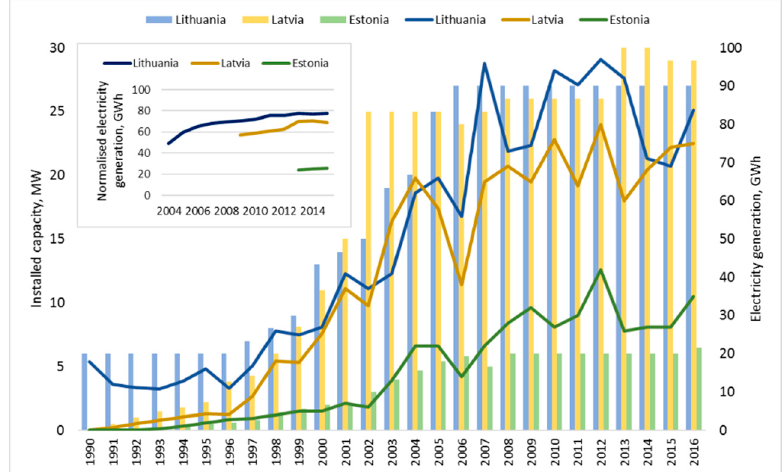
Figure 6. The installed capacity and electricity generation of small hydropower plants in the Baltic States for the period from 1990 to 2016.